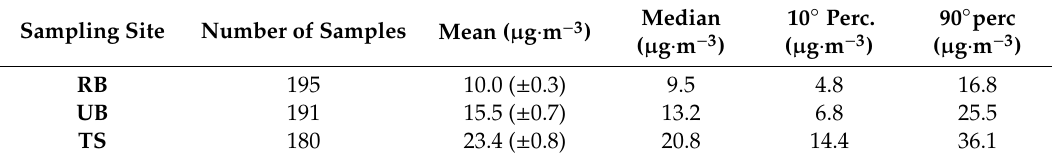
Table 1. Mean (± standard deviation of the mean), median, 10° and 90° percentiles of PM 2.5 mass Table 1. Mean ( ± standard deviation of the mean), median, 10 ◦ and 90 ◦ percentiles of PM 2.5 mass concentrations of daily samples collected in the TS, UB and RB sampling sites. concentrations of daily samples collected in the TS, UB and RB sampling sites.